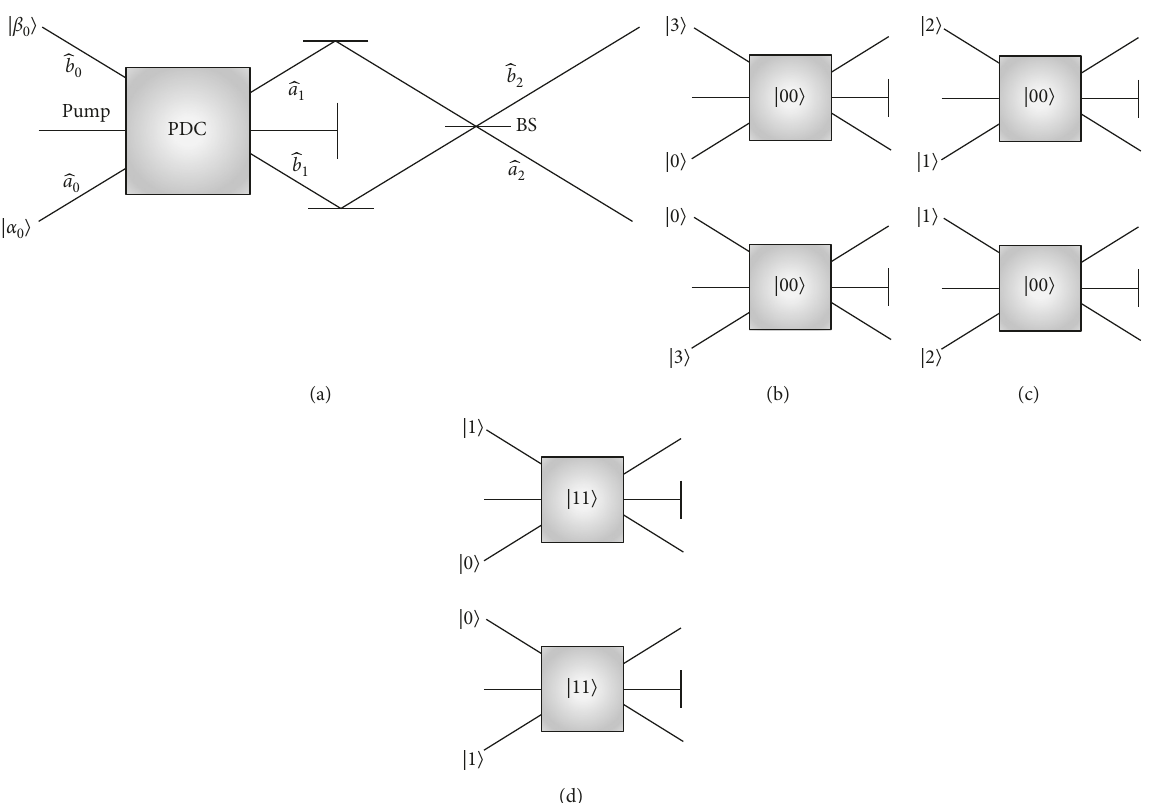
Figure 3: (a) The setup for mixing laser and noncollinear PDC lights at a BS. There are six distinct ways to mix laser and PDC photons leading to 3-NOON state: (b) No photons from PDC, 3 photons from upper laser, no photons from lower laser, and vice versa. (c) No photons from PDC, 2 photons from upper laser, 1 photon from lower laser, and vice versa. (d) 2 photons from PDC, 1 photon from upper laser, no photons from lower laser, and vice versa. Compare this to Figures 1(b), 1(c).